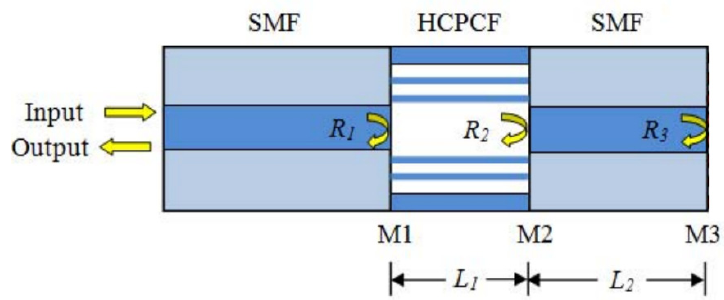
Figure 10. Schematic of the optical fiber FPI. Reproduced from ref. [70] with permission from Elsevier.